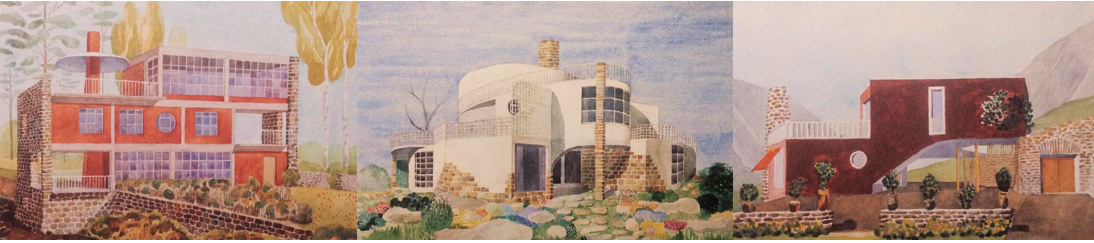
Figure 2. Watercolours of houses n. 8, n. 9 and n.